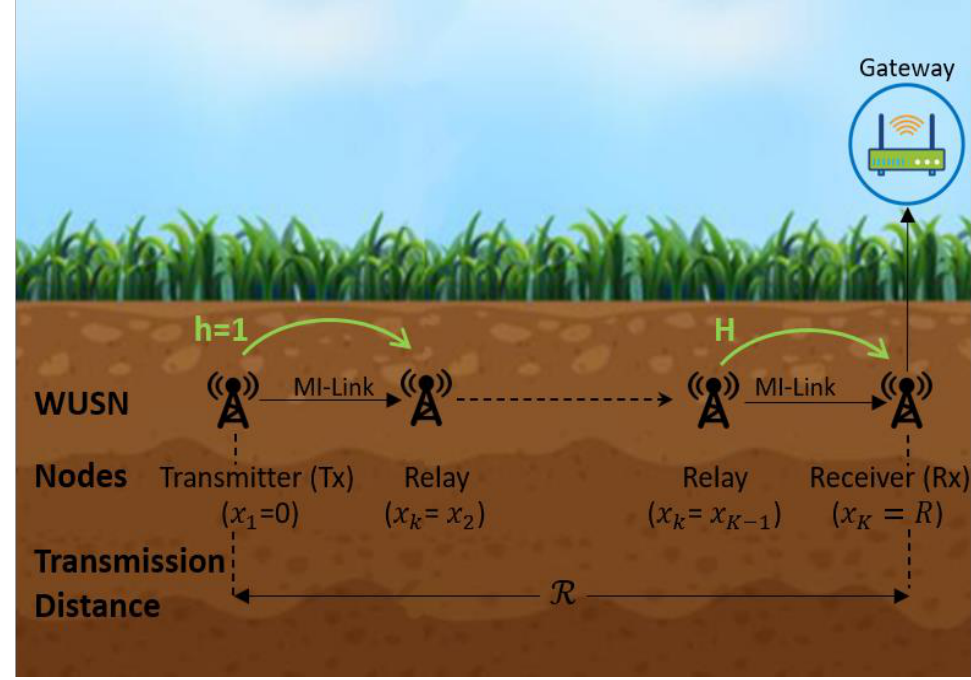
Figure 3. Proposed multihop MI communication system.